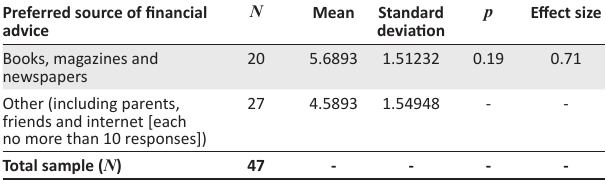
TABLE 9: The preferred source of personal finance advice.